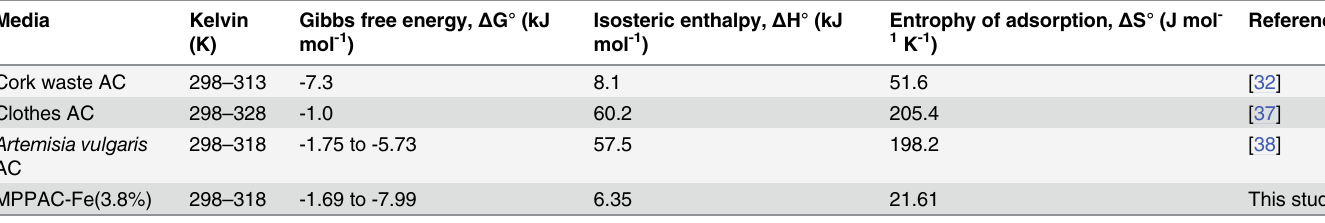
Table 3. Gibb ’ s free energy change, enthalpy change and entropy change for IBP adsorption.